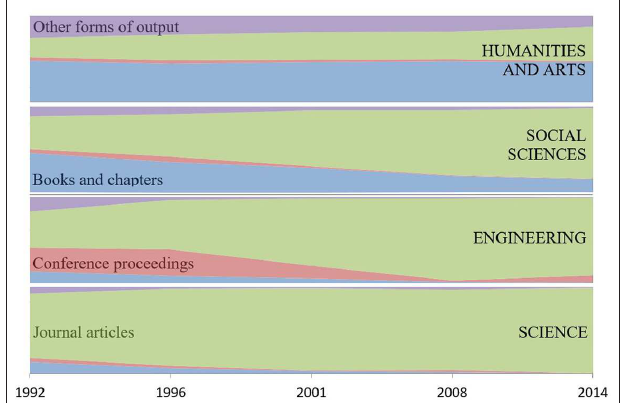
FIGURE 1 | Variation in relative frequency of types of submitted output across successive cycles of the UK Research Assessment Exercise (1992–2008) and Research Excellence Framework (2014). Data are shown for four principal output types and are aggregated for Units of Assessment in four research domains corresponding to the “main panels” of the 2014 exercise. The data show a reduction in diversity with a convergence on journal articles in all areas except Humanities and Arts.